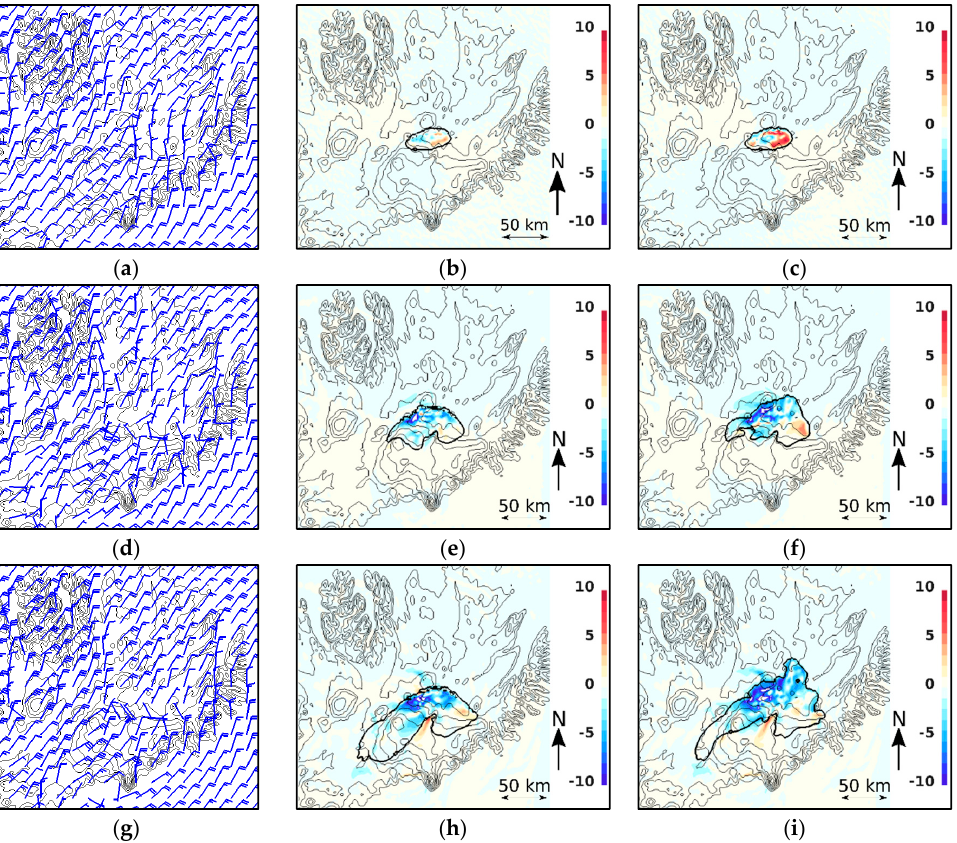
Figure 14. ( a ) Left-hand panel ( a , d , g ): wind barbs in the absence of any gas release for the November 2014 Holuhraun fissure example. Middle panel ( b , e , h ): difference in 10 m wind speed between 6 g kg − 1 release and no-release case. Right-hand panel ( c , f , i ): difference in wind speed between 200 g kg − 1 release and no-release case. In all three panels wind speed is shown colour-shaded (ms − 1 ), topography is shown with solid contours (250 m intervals) and the solid black line represents lowest-level concentration of SO 2 equal to 1 g kg − 1 . ( a – c ): 10 min after eruption, ( d – f ): 60 min after eruption, ( g – i ): 120 min after eruption. In all plots the horizontal extent is 345 km (west-east) by 265 km